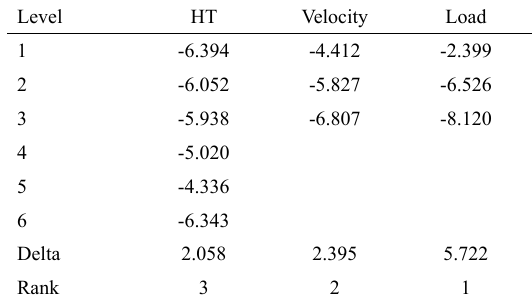
Table 5. Response table for S/N